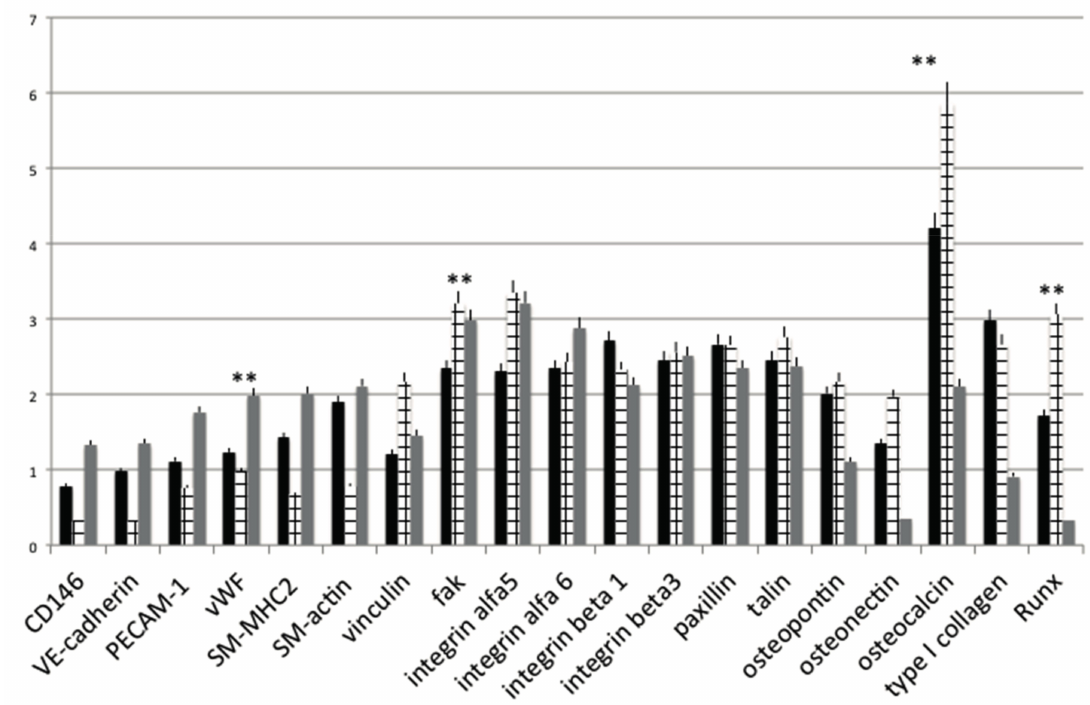
Figure 7. Gene expression profiles of osteogenic, cell adhesion molecules and endothelial differentiation markers in MSC cultured in presence of non differentiative medium: (black bars), osteoinductive medium (squared bars); HUVEC (grey bars.) seeded onto control or OGI surfaces. Values are expressed as 2 ∆∆ Ct . Statistically significant differences are indicated as ** p <